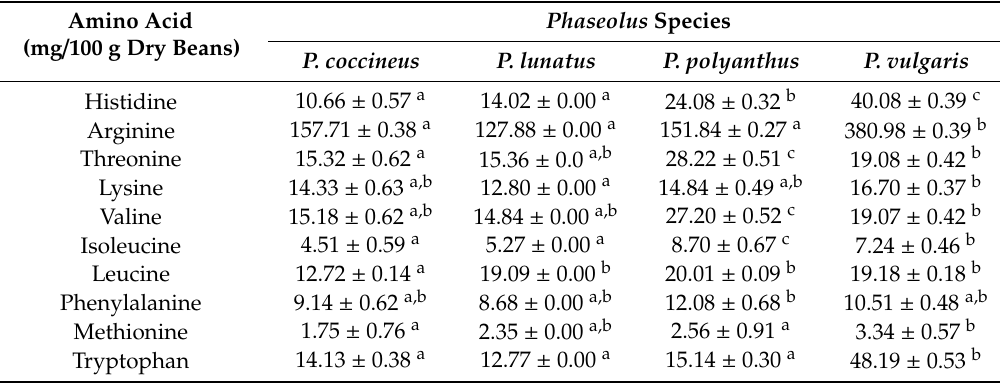
Table 2. Free amino acid content from Phaseolus species grown in the Mayan Region. Amino Acid